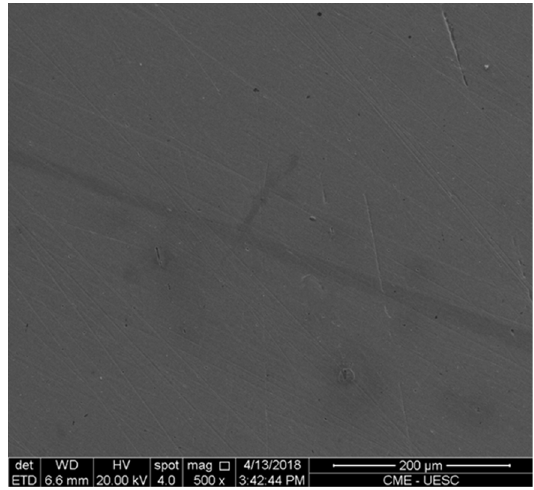
Figure 10. SEM Micrograph of the SAE 1008 carbon steel before immersion in the